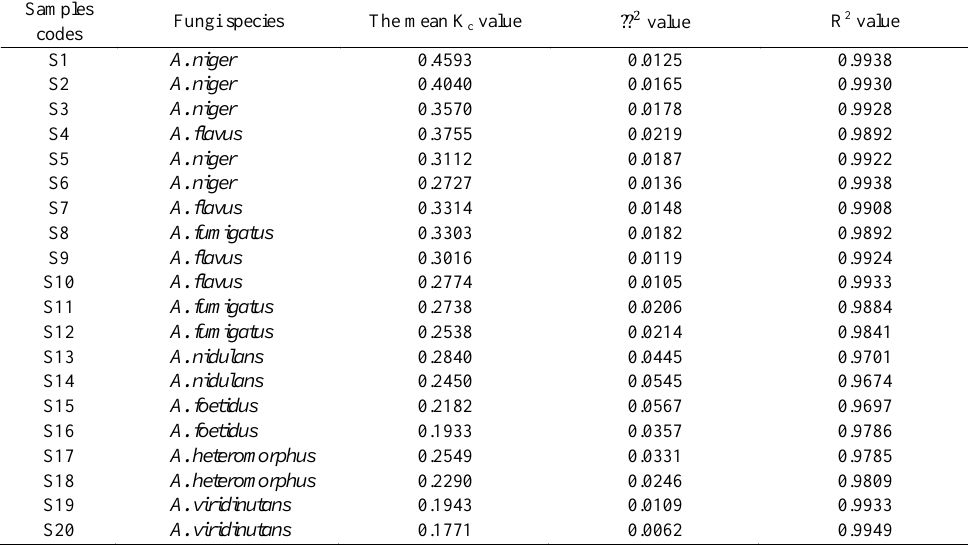
Table 9: The biosorption rate constant, coefficient of determination and Chi-square values for the degradation of Cr(VI) in a tannery industry wastewater by an isolated fungi species Samples